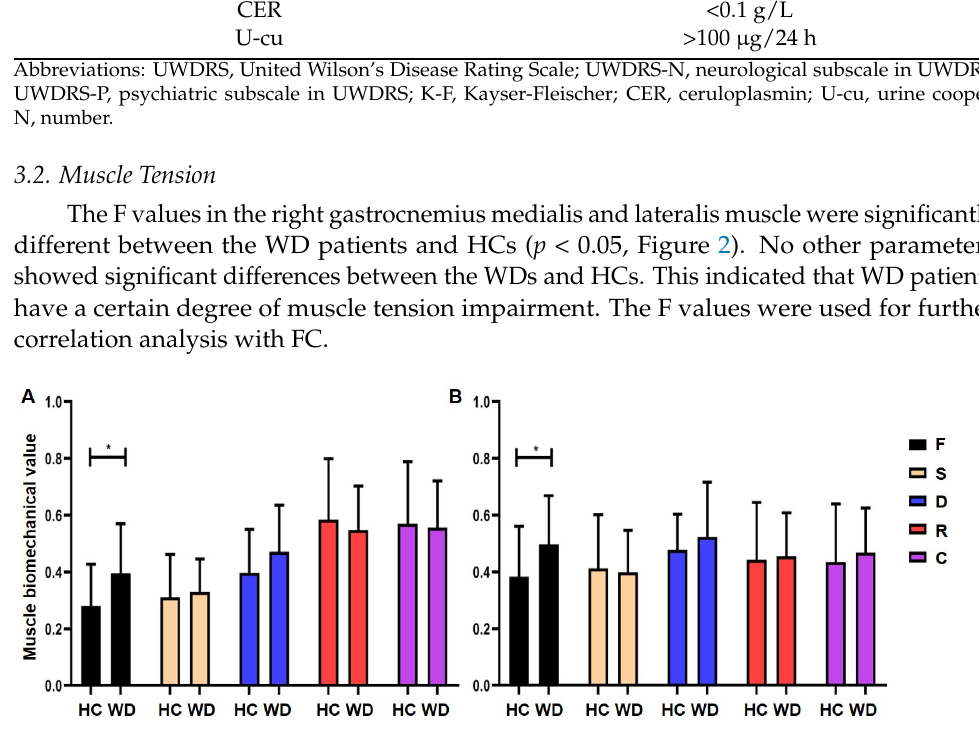
Table 1. General and clinical characteristics of the included WD patients.